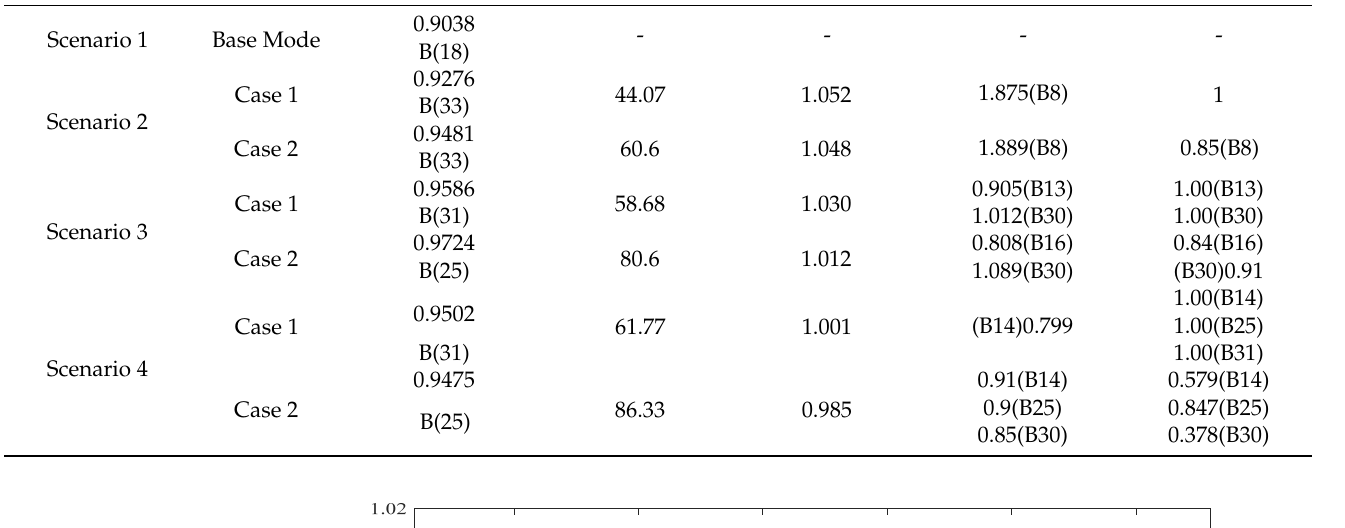
Table 3. Results in minimize total cost.